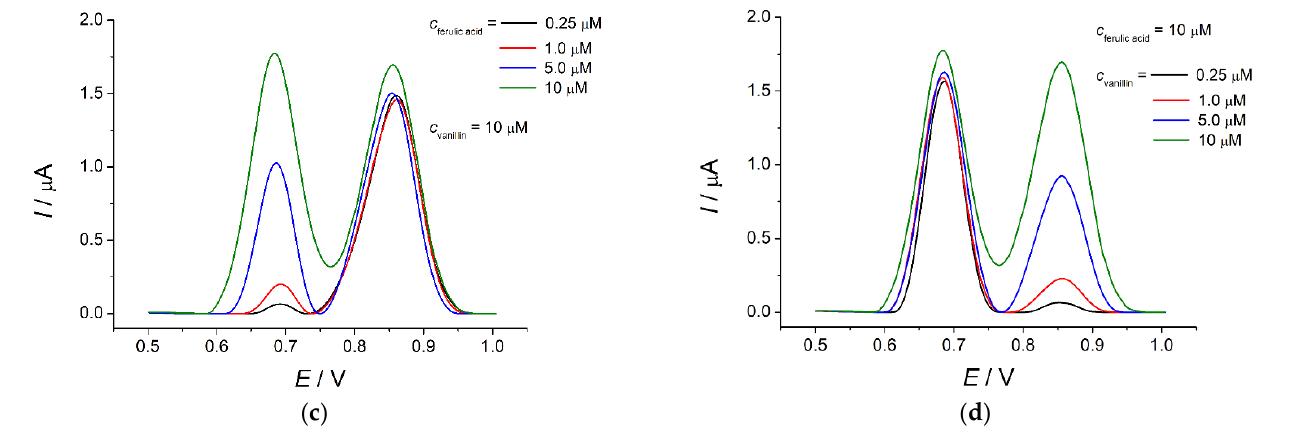
Figure 11. ( a , b ) Baseline-corrected DPVs of equimolar mixtures of ferulic acid and vanillin on polyBCP/f-SWCNTs/GCE in BRB, pH 2.0; concentration ranges are 0.10–5.0 µ M ( a ) and 5.0–25 µ M ( b ). ( c ) Baseline-corrected DPVs of non-equimolar mixtures of ferulic acid and vanillin (various concentrations of ferulic acid at the fixed 10 µ M concentration of vanillin). ( d ) Baseline-corrected DPVs of non-equimolar mixtures of ferulic acid and vanillin (various concentrations of vanillin at the fixed 10 µ M concentration of ferulic acid). ∆ E pulse = 75 mV; t pulse = 25 ms; υ = 10 mV s − 1 .